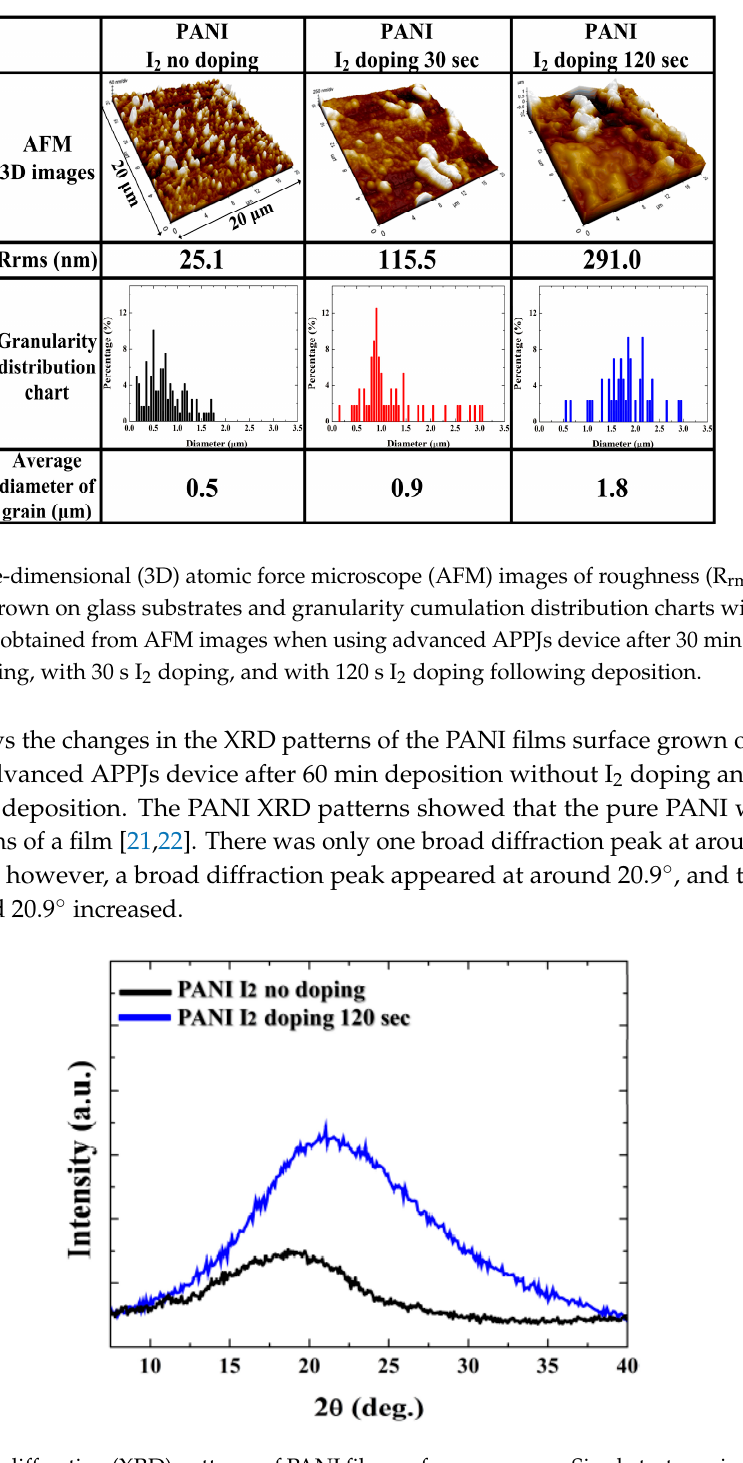
Figure 4. X-ray diffraction (XRD) patterns of PANI film surfaces grown on Si substrates using advanced APPJs device after 60 min deposition without I 2 doping and with 120 s I 2 doping following deposition.